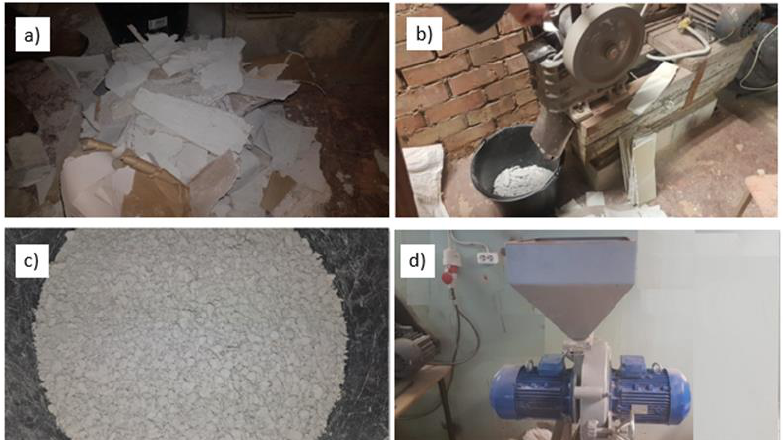
Figure 1. The treatment process of CDW to obtain secondary gypsum powder for binder produc- tion: ( a ) collection of gypsum wallboard CDW; ( b ) crushing of wallboards with laboratory jaw crusher; ( c ) gypsum CDW aggregate (<11.2 mm) prepared for milling; ( d ) gypsum CDW milling in disintegrator (collision